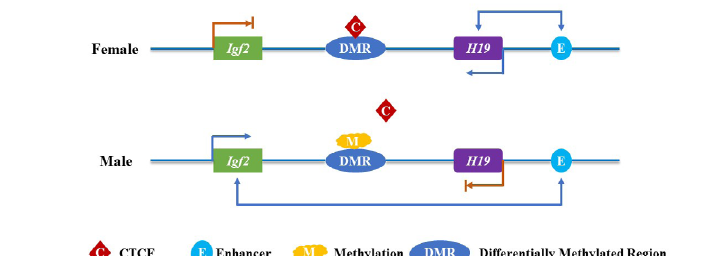
Figure 1. Gene imprinting. The methylation of the paternal allele DMR affects the binding of CTCF, and the enhancer downstream of H19 can interact with the Igf2 over a long distance to promote its expression. On the contrary, the maternal allele DMR is not methylated, which means CTCF can bind to it and then block the interaction between the downstream enhancers of H19 and the promoters of Igf2 . As a result, the expression of Igf2 is turned off, but H19 can still be expressed under the action of downstream enhancers